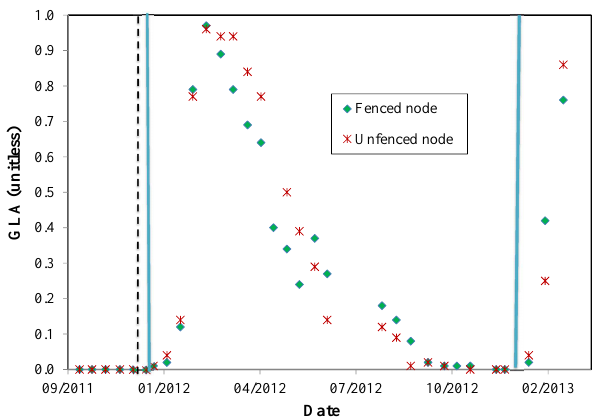
Figure 7. Time series of the green leaf algorithm (GLA) calculated from digital camera images at each node, using a daily image from approximately 12:00. The black dashed vertical line indicates the timing of the controlled burn and the blue lines the start of the wet seasons. See Fig. 5 for a time series of the %Green3D and %Green2D field